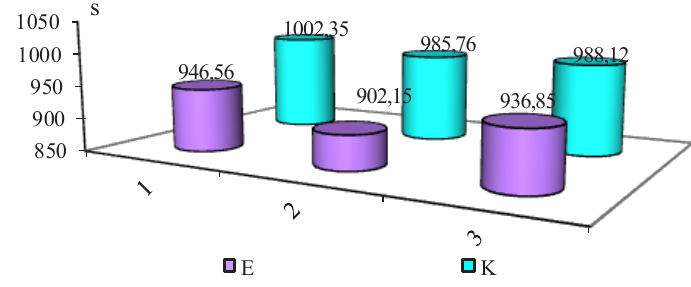
Fig. 3. Indicators of endurance manifestation of girl-students of the experimental and control groups after the experiment. s– seconds; B – experimental groups; K – control groups; 1, 2, 3 – numbers of